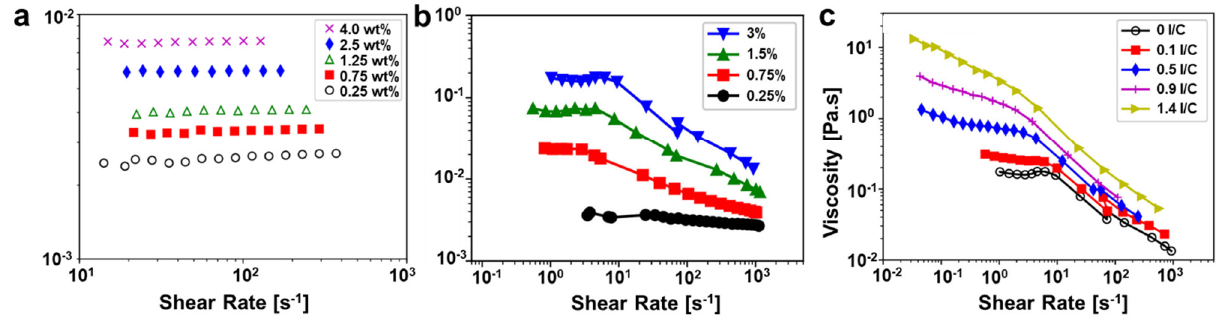
Figure 5. Viscosity of Nafion ionomer dispersions ( a ), Pt/HSC dispersions ( b ), Pt/HSC and ionomer dispersions with a fixed 3 wt.% carbon ( c ) in 1-propanol and aqueous solvent mixture (3:1 mass ratio) at different concentrations or I/C ratios (Reprinted with permission from ref. [53]. Copyright (2018) American Chemical Society).